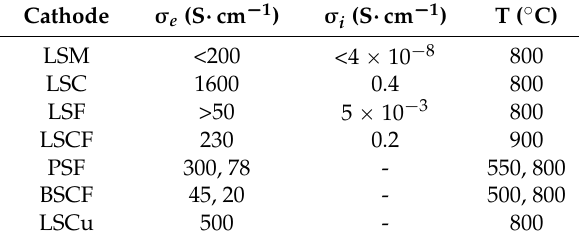
Table 2. Electronic and Ionic Conductivities of various families of SOFC cathode [8].